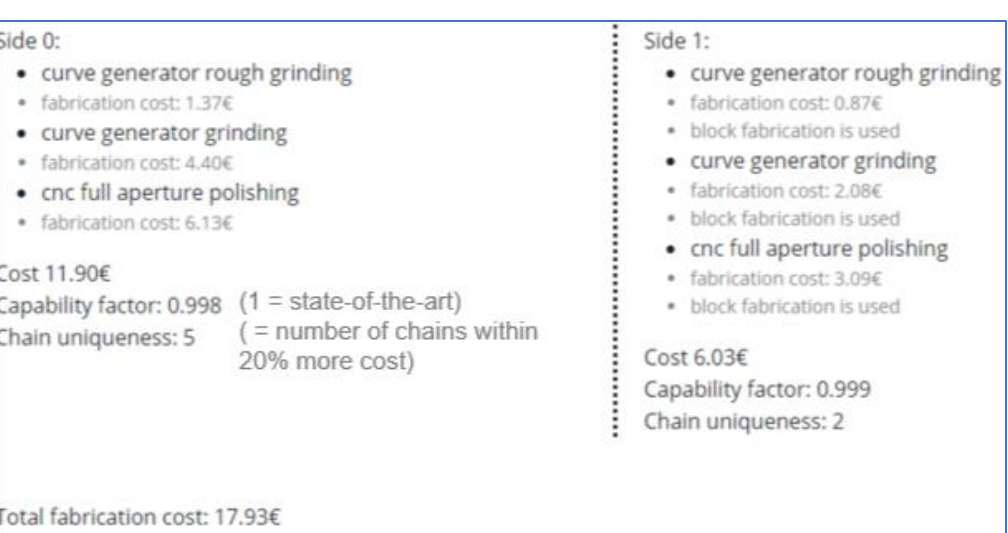
Fig.4. Modeling the generation of the biconvex lens shown in Fig.3: identification of the optimum optical fabrication technologies needed for the minimum-cost fabrication